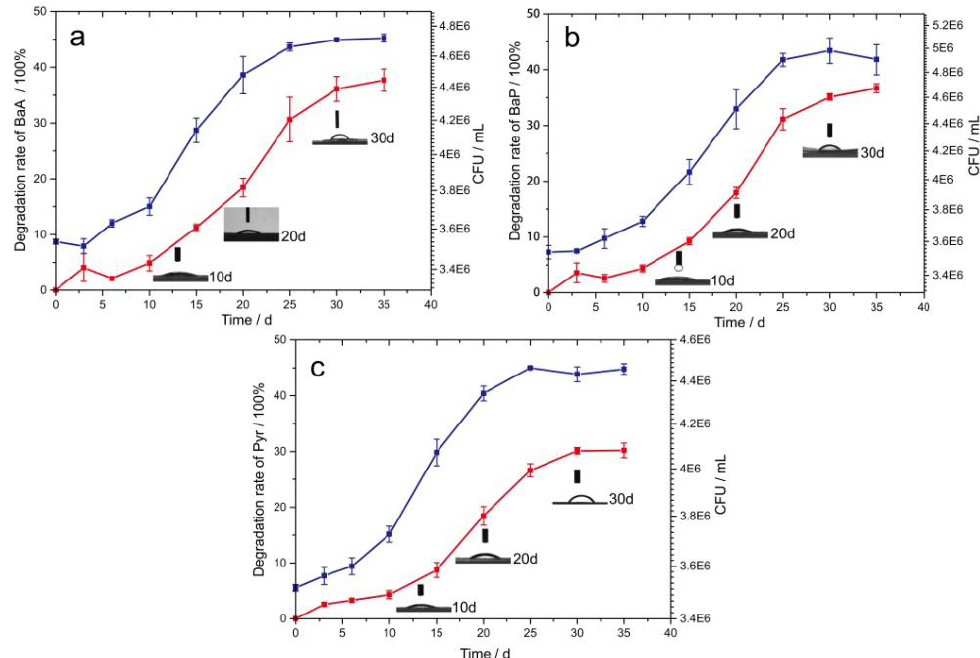
Figure 4. PAH-2 degradation rates of ( a ) BaA, ( b ) BaP, and ( c ) Pyr and the bacteria number during the degradation process changes with time and the black inserts (10, 20, 30 d) represent the bacterial hydrophobicity during degradation. Each experiment was repeated three times to ensure repeatability and accuracy of the data.